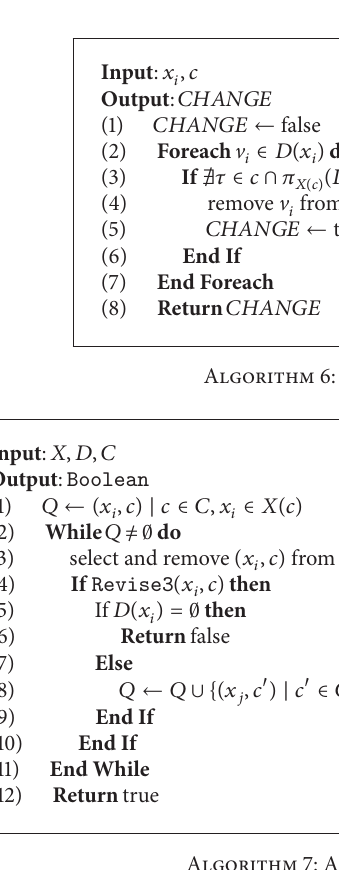
Figure 2: Enforcing AC3 to a subgrid